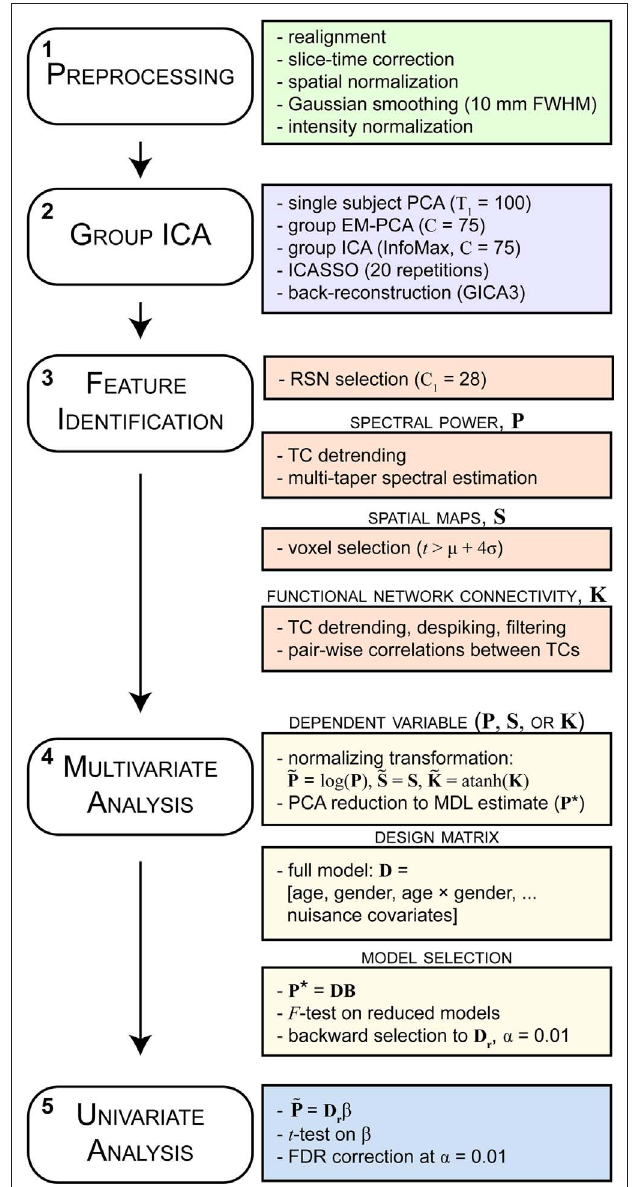
FIGuRe 1 | Schematic of the analysis pipeline. Boxes on the left indicate general steps potentially applicable to a variety of data and analysis types; boxes on the right indicate particular choices made for the data and analysis presented here. See Section 2 for details and